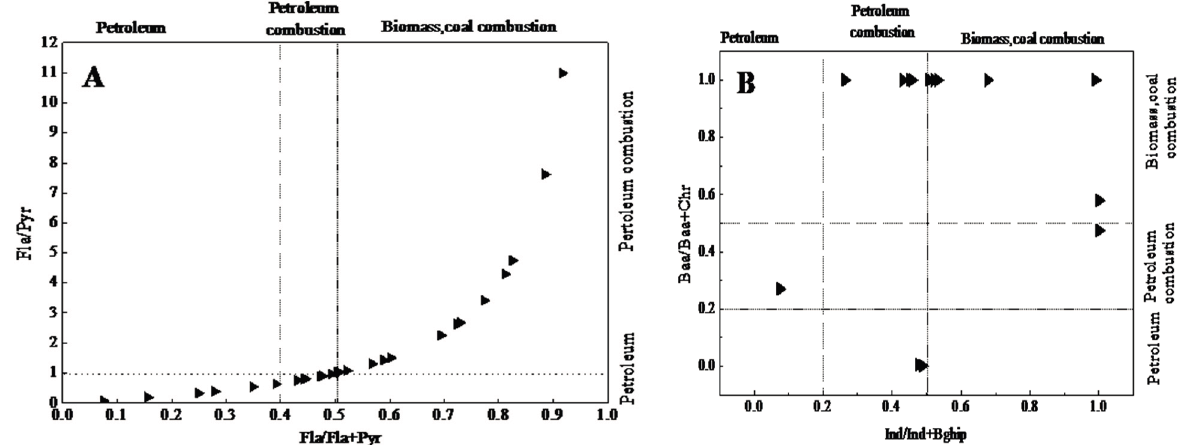
Figure 4. PAHs cross plots for ratios of Fla/Pyr vs. Fla/(Fla + Pyr); Baa/(Baa + Chr)